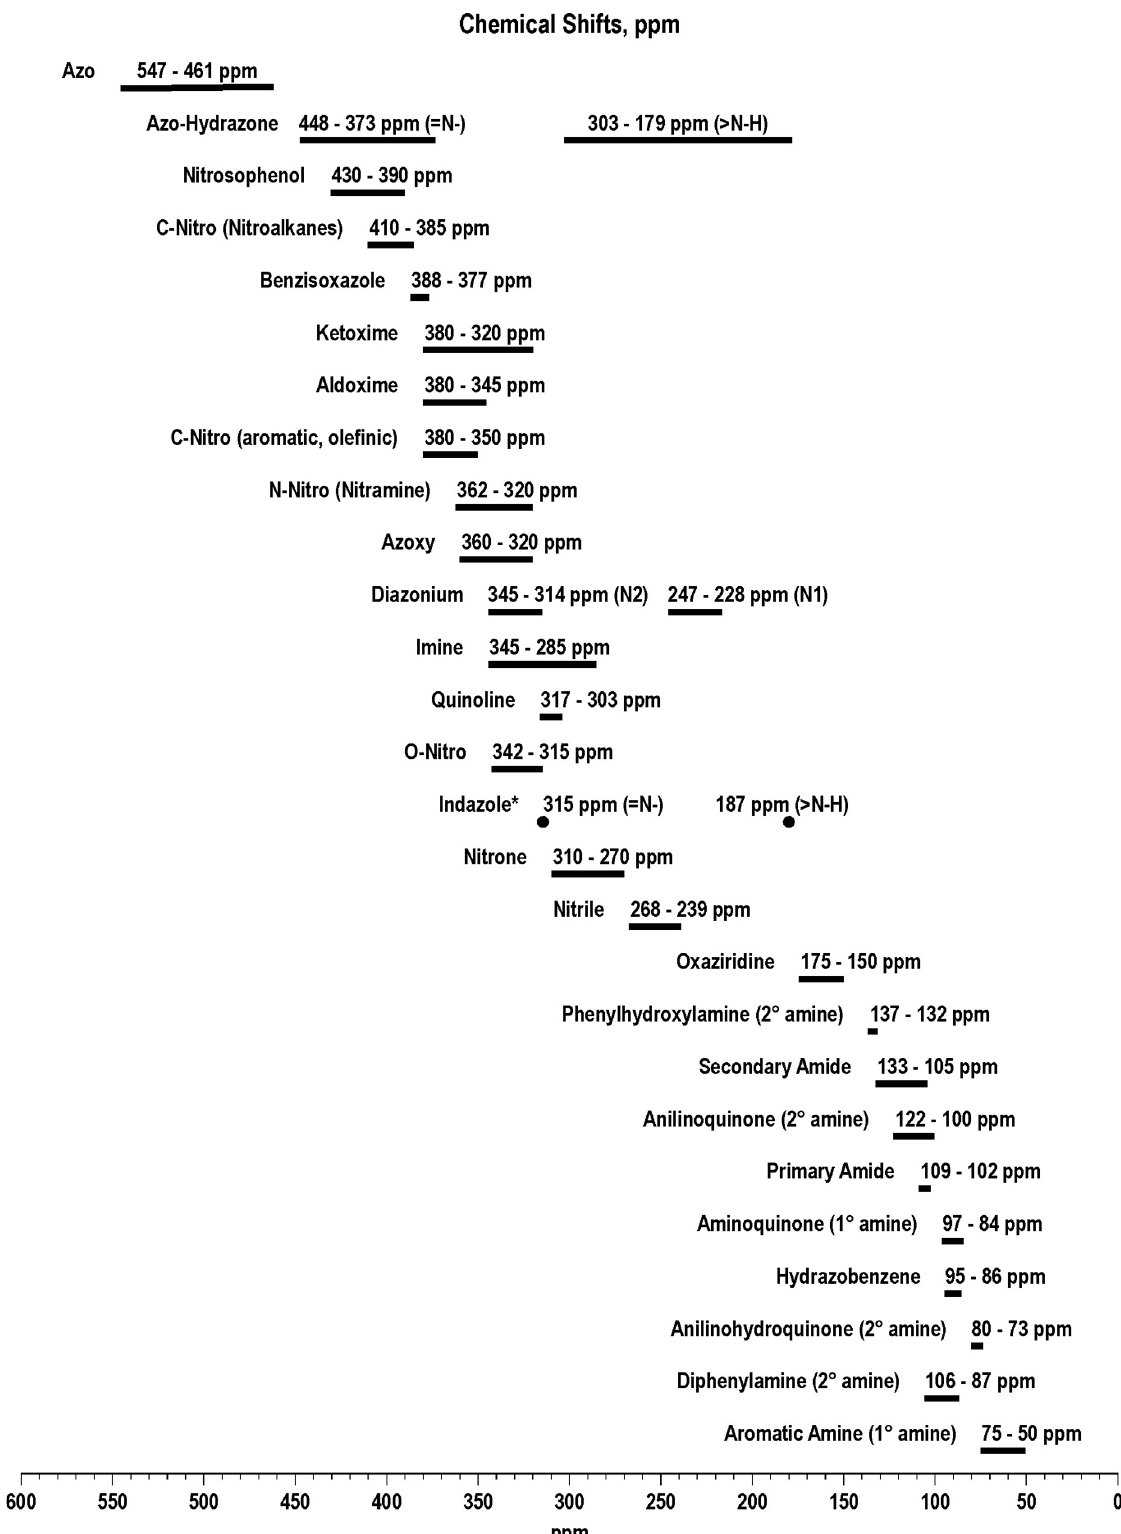
Fig 8. N-15 NMR chemical shift ranges of nitrogen functional groups. � Based on shifts for a single indazole structure.